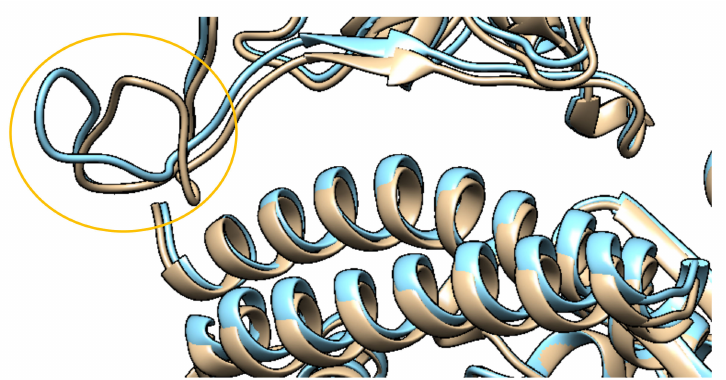
Figure 8. Structural superimposition between the wild-type RBD (Tan) (PDB 6M0J) and with the G485R RBD mutation (Cyan) (PDB 7LO4), with conformational change in the highlighted loop. The RMSD between structures is 0.42Å